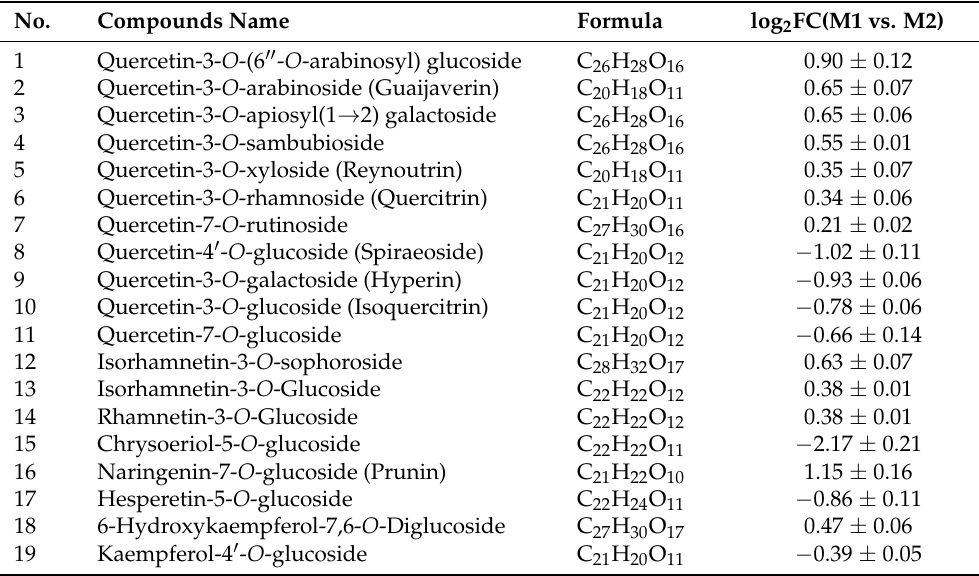
Figure 2. Distribution and classification of DAFs in M1 vs. M2. Table 1. Classification of DAFs and their differential accumulation levels in M1 vs. M2 (mean ± SD, n =